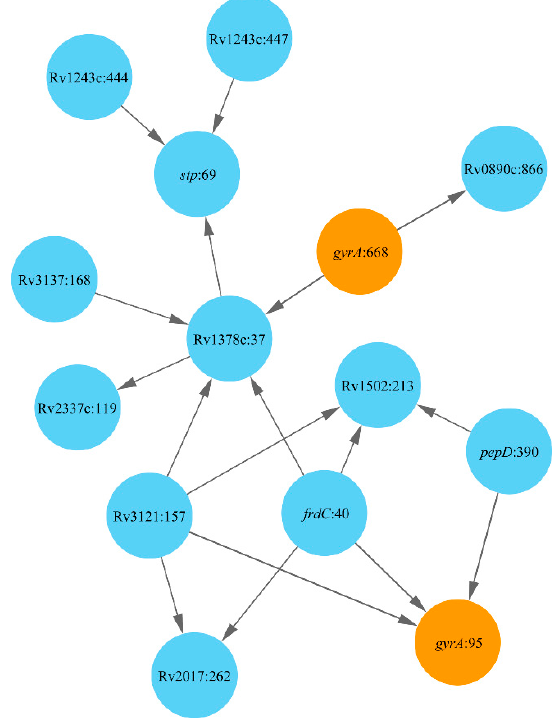
Figure 1. Network of DR-associated mutations in Lineage 1.2. Polymorphic loci are shown as nodes titled by the respective gene name and the polymorphic codon number following the colon. Mutations known to cause DR are depicted by color. Arrows show relations between prerequisite and subordinate mutations.